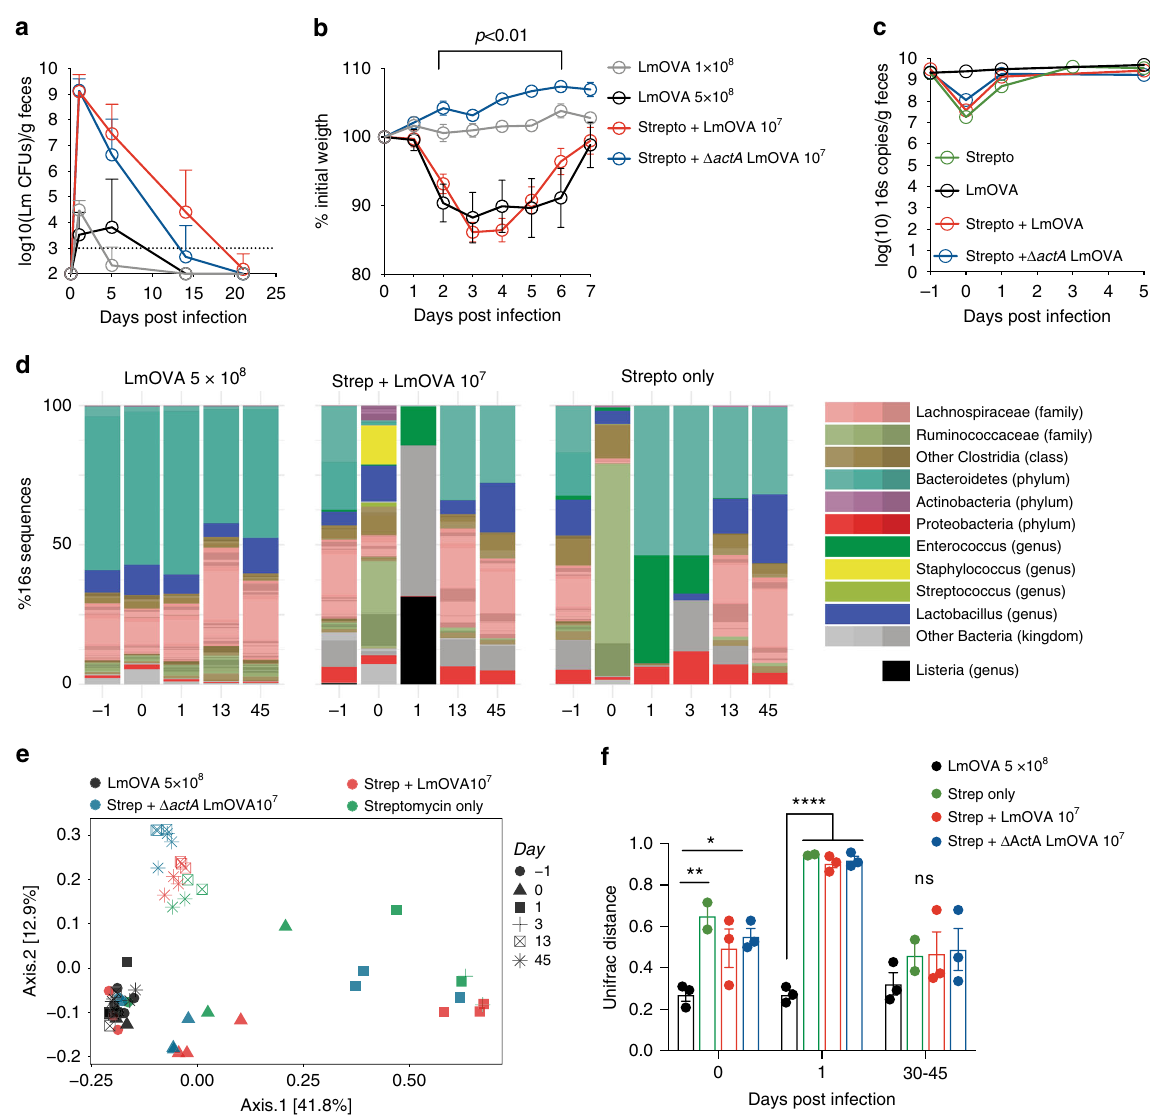
Fig. 1 Antibiotics promote temporary depletion of the microbiota and transient expansion of Lm in the intestine. a Fecal shedding of Lm following oral inoculation with different strains performed on mice that had been pre-treated with either PBS or streptomycin at d-1 (for groups listed as in fi gure: n = 9, 10, 15, 10 from 3, 3, 5, and 3 independent experiments, respectively; shown are geometric means ± geometric SD). b Weight loss curve for mice treated as shown in a (for groups listed as in fi gure: n = 9, 7, 14, 11 from 3, 2, 5, and 4 experiments, respectively; Two-way ANOVA with multiple comparisons, p < 0.01, p < 0.001 and p < 0.0001 at all time points in the indicated time frame between either of the groups: LmOVA 1 × 10 8 and Strepto + Δ actA LmOVA 10 7 and either of the groups: LmOVA 5 × 10 8 and Strepto + Δ actA LmOVA 10 7 ; shown are means ± SEM). c Microbiota density in fecal pellets as measured by quantitative 16s gene PCR in mice treated as depicted; 0 refers to the day of infection ( n = 6 from 2 experiments except d5 n = 3 from one experiment, n = 2 for Strepto-only group; shown are geometric means). d Representative bar graph depicting the composition of the microbiota as assessed by 16s rRNA gene sequencing, for one experiment conducted as described in a , b (each bar represent pooled data from three mice). e Unweighted Unifrac Principal Coordinates Analysis (PCoA) of microbiota composition, based on 16s rRNA gene analysis, for mice treated as depicted in the legend. f Overtime Unifrac distance from the baseline microbiota (day − 1) obtained from 3 independent experiments performed as the one shown in d , e (each dot represents one experiment, i.e. average value from 2 – 3 mice, Two-way ANOVA with multiple comparisons, shown are means ± SEM). (For all analyses: * p < 0.05, ** p < 0.01, *** p < 0.001, **** p <